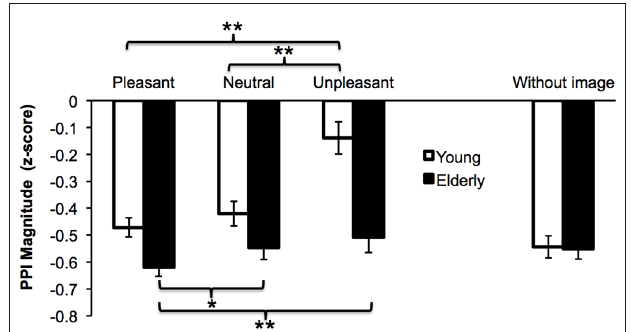
FIGURE 3 | Mean normalized PPI magnitude prepulses while viewing pleasant, neutral and unpleasant images for Younger adults and Elderly. The without-image condition is shown for comparison. Error bars are standard errors. ∗ p < 0.05; ∗∗ p <